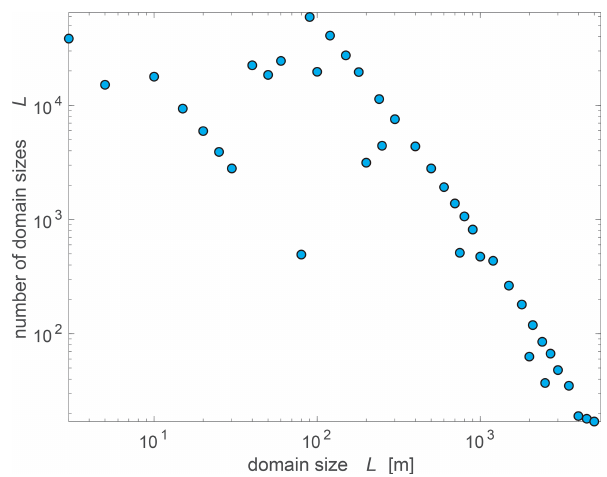
Figure 4. Total number of valid domain sizes L per domain size L in log–log